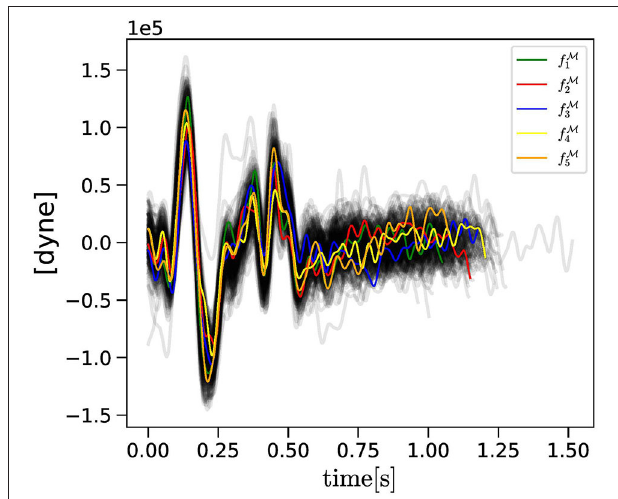
FIGURE 1 | The collection T M f of BCG curves measured experimentally (gray curves) are reported along with the f M k , with k = 1, ... , N c = 5, consecutive curves selected randomly as objective curves for the evolutionary algorithm (EA) applied to Subject